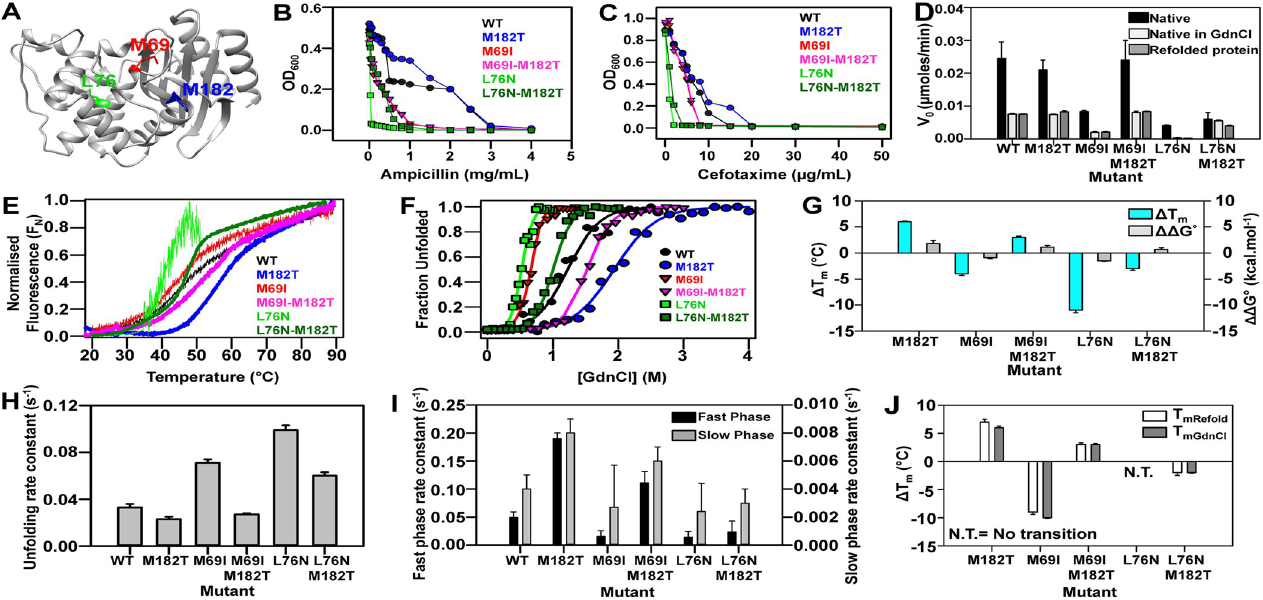
Fig 3. Enhancement of protein stability by M182T global suppressor in extended spectrum TEM-1 β -lactamases. (A) Inactive mutants and distal suppressor M182T mapped onto the crystal structure of TEM-1 (PDB ID 1XPB [76]). The TEM-1 protein is shown in ribbon with the distal suppressor M182T, mapped on an exposed region, while the inactive mutants L76N and M69I are present in the core of the protein. (B-C) Influence of M182T substitution on TEM-1 mediated MIC levels using ampicillin (B) and cefotaxime (C) broth dilutions and pET24a plasmid. (D) The initial velocity (V 0 ) of the native enzyme (black), protein in 0.5 M GdnCl (light grey) and refolded protein in 0.5 M GdnCl (dark grey) at 25˚C with 10 nM protein and 50 μ M of nitrocefin. (E-F) Thermal unfolding profiles and equilibrium GdnCl denaturation profiles of 10 μ M of purified WT, and TEM-1 β -lactamase mutants. (G) The difference in thermal stability, Δ T m ð D T ¼ T (cid:0) T Þ of native proteins (in cyan), and thermodynamic stability assayed by chemical denaturation, ΔΔ G˚ ð DD G � ¼ m m Mutant m WT D G � (cid:0) D G � Þ of the different TEM-1 mutants (in grey). (H-I) The observed rate constants of unfolding (2.5 M GdnCl) and the observed rate constants of Mutant WT the fast phase (black) and slow phase (grey) of refolding (0.5 M GdnCl) of different mutants are represented. (J) The difference in thermal stability ð D T (cid:0) T Þ of 10 μ M of native proteins (white) and refolded proteins in 0.5 M GdnCl (grey). The error bars wherever shown represent the standard T m Mutant m WT deviation from two independent experiments, each performed in